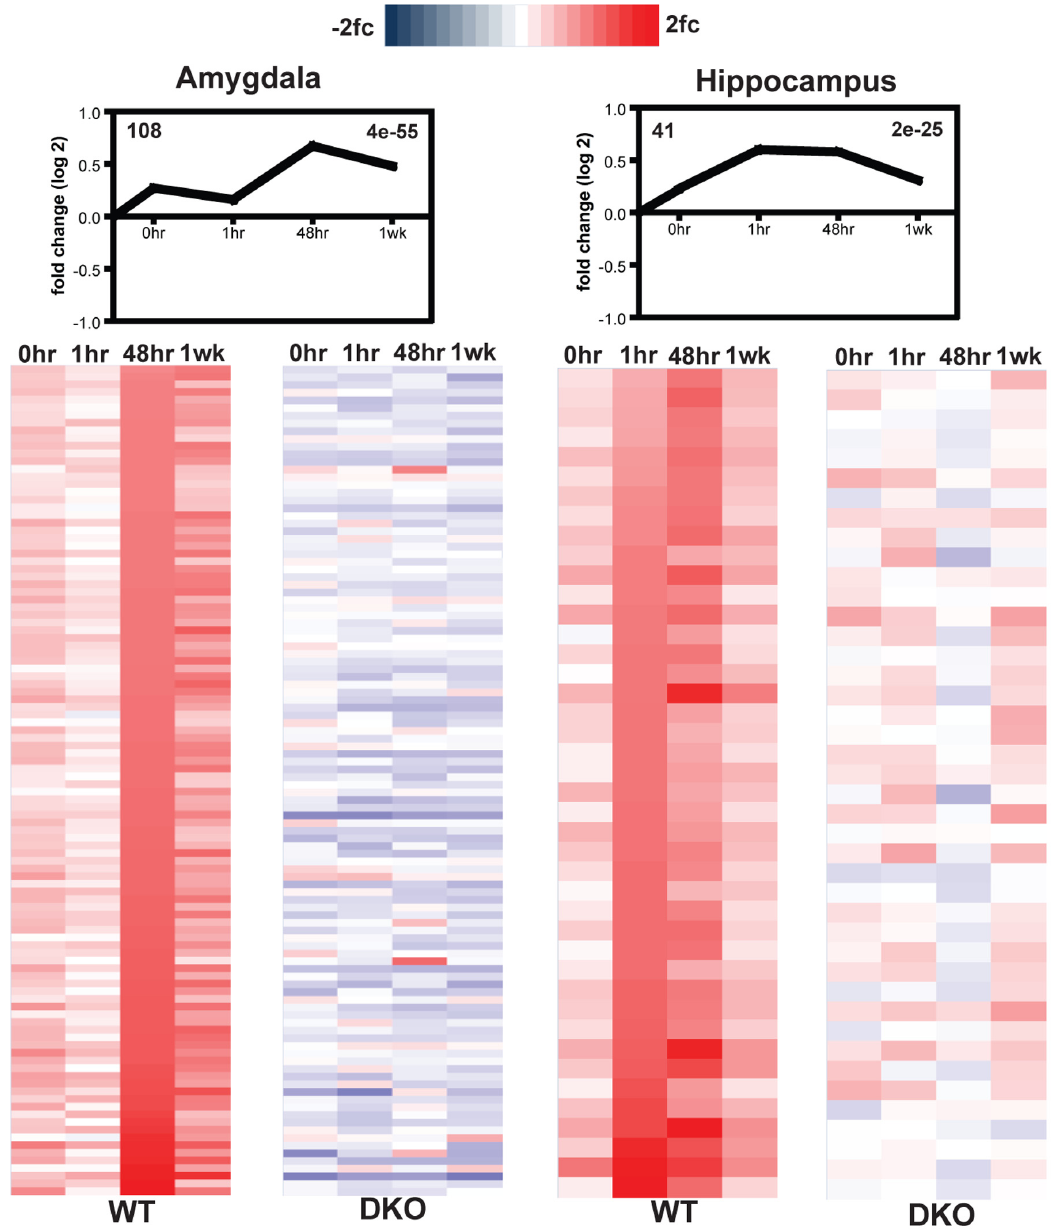
Figure 4. Heat map analysis reveals divergent gene expression changes. A heat map was generated for the most significant cluster in each brain region of WT mice. The gene changes are mapped in the WT mice, and the respective changes in expression of the same genes are mapped in the DKO mice. ( A ) The amygdala results reveal not only a suppression, but opposing regulation in gene expression in DKO mice. ( B ) The hippocampal results reveal an overall suppression in gene changes within DKO mice.